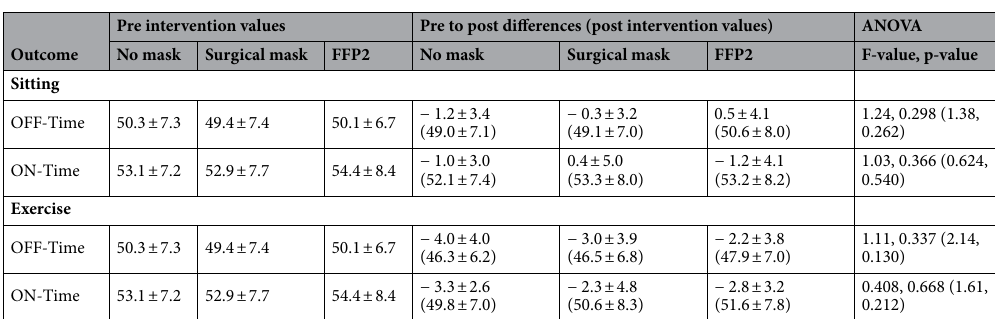
Table 3. Pre intervention and pre to post intervention differences of cognitive attention (Stroop OFF-Time) and executive function (Stroop ON-Time) performance for the sitting and exercise intervention with no mask, surgical mask or filtering face piece type 2 (FFP2). Values are displayed as mean ± standard